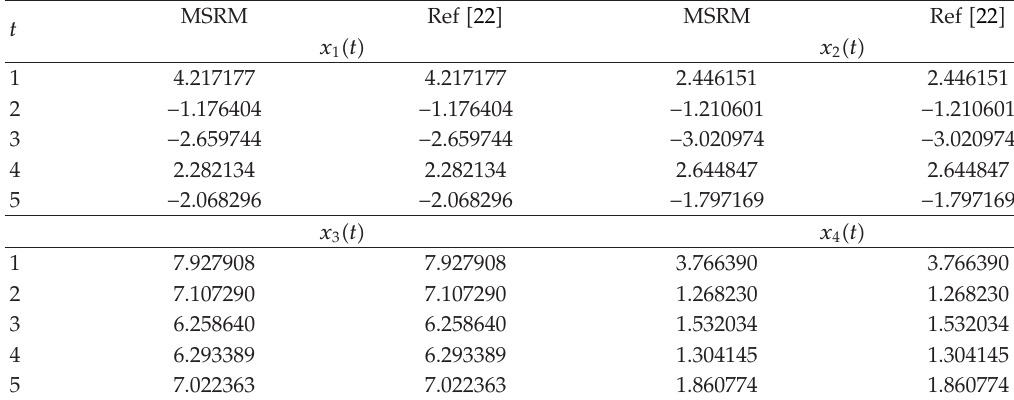
Table 4: Comparison of the numerical solution of the hyperchaotic Chen system obtained by the MSRM and ode45 with d (cid:9)